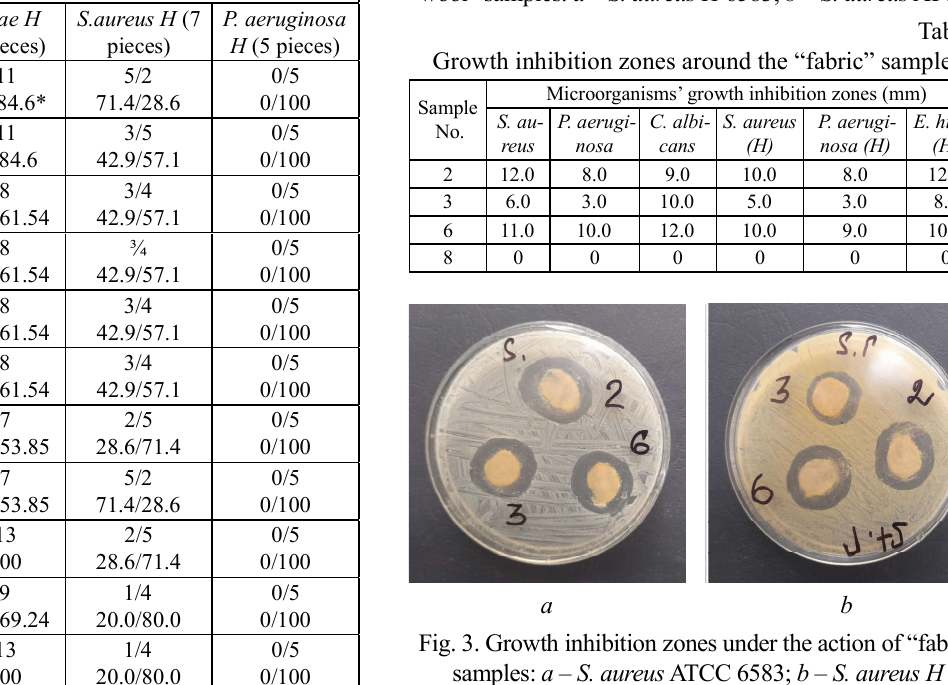
Fig. 2. Growth inhibition zones under the action of “cotton wool” samples: a – S. aureus H 6583; b – S. aureus ATCC